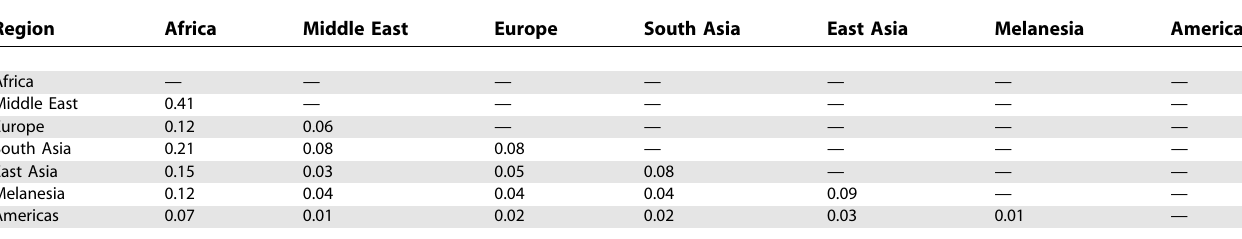
Table 5. Bi-Continental Allele Sharing, Corrected by Combined Sample Sizes